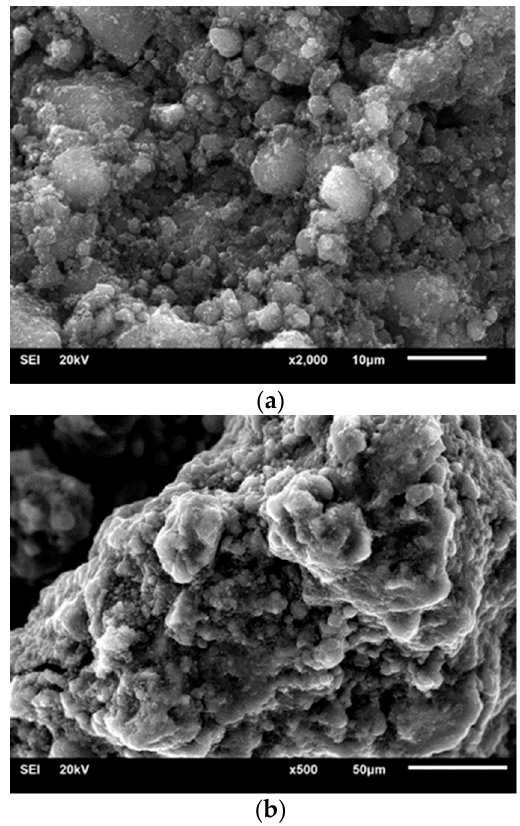
Figure 6. SEM images of the obtained doped graphene materials — sample A1 ( a ) and A5 ( b